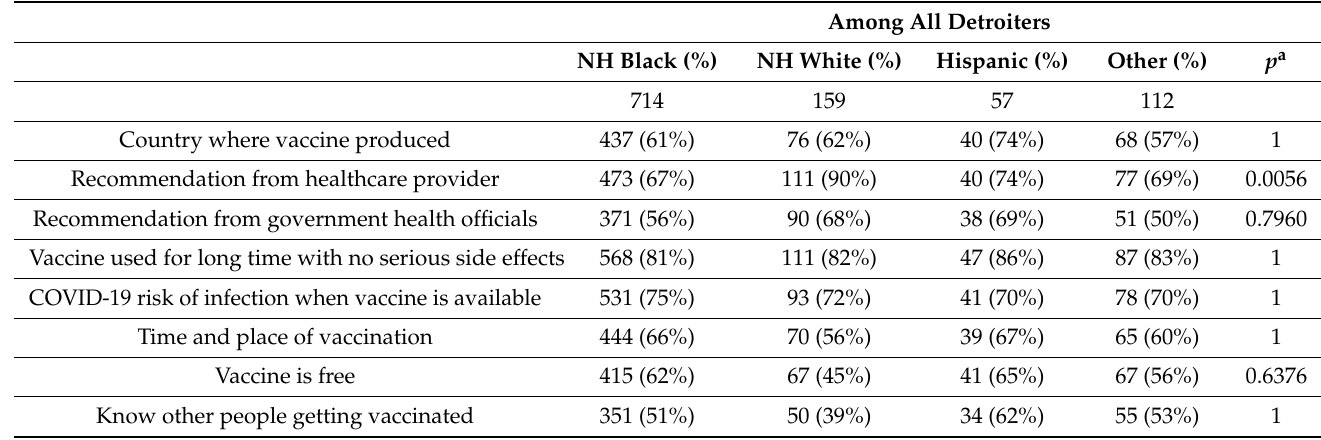
Table 3. Importance of additional factors in an individual’s intention to become vaccinated, stratified by race/ethnicity, and by gender among Black Detroiters, October 2021.